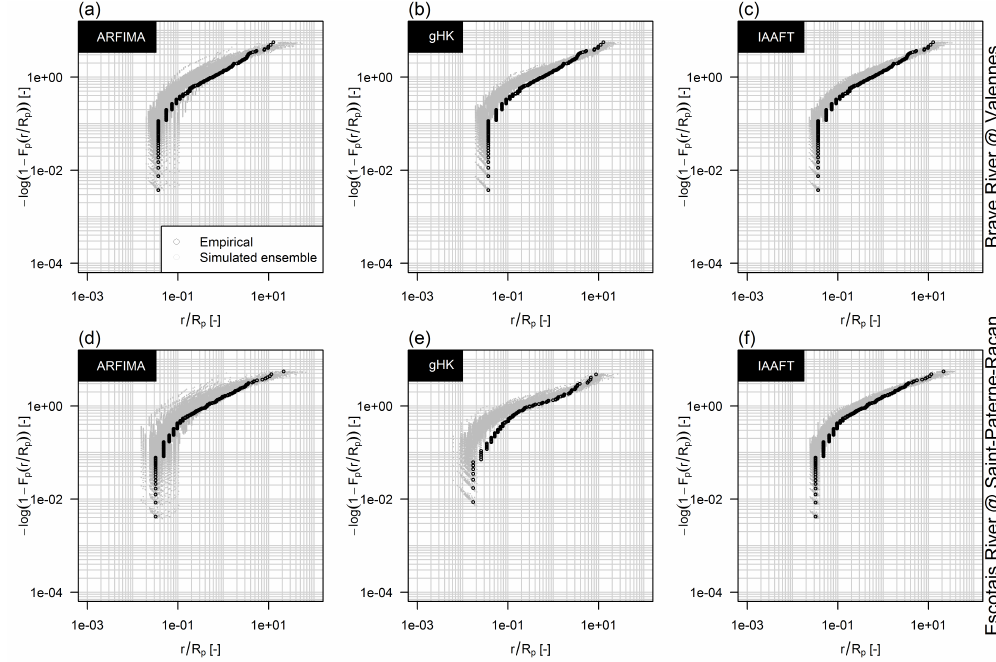
Figure 13. Survival functions of the standardized return intervals between standardized flow values exceeding the 95% quantile threshold. Black circles correspond to the observed series while grey circles indicate an ensemble of 100 simulated time series with the same length of the observed ones. Panels ( a – c ) refer to the Braye River while panels ( d – f ) to the Escotais River. The same interpretation of Figure 10